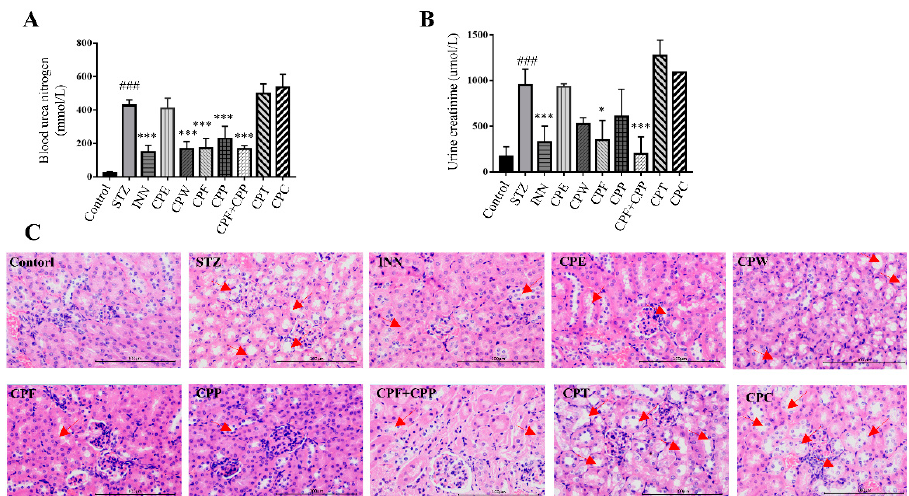
Figure 5. CPF (flavonoids fraction from C. paliurus leaves) and CPP (polysaccharide fraction from C. paliurus leaves) improved nephropathy in STZ (streptozotocin)-induced diabetic mice ( A ) The blood urea nitrogen levels of all CP treatment group. ( B ) The urine creatinine levels of all CP treatment groups. ( C ) Representative H&E staining of the kidney. Scale bar = 100 µ m. The exfoliated renal tubes are indicated by the red arrows. n = 6, ### p < 0.001, STZ vs. control, * p < 0.05, *** p < 0.001, STZ vs. treatment.